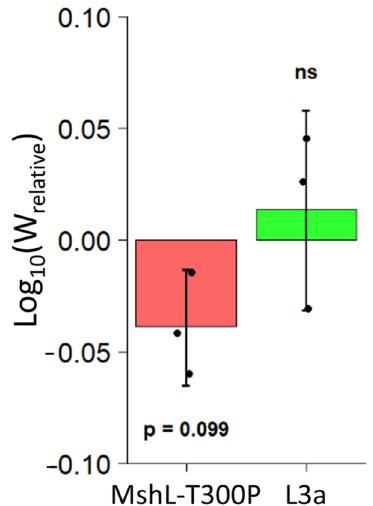
Figure 3. Competitive fitness of L3a and MshL-T300P mutant in vivo. Competitive in vivo growth rates were calculated (see methods) and then used to determine a relative in vivo fitness metric [32]. Each point represents the mean for a single competition flask where 10 colonized larvae were dissected at an initial time point and 10 larvae were dissected 10 h later. Each group of points was t -tested against the value zero, our expected value if there were no competitive advantage. No significant difference is indicated by “ns” (not significant).